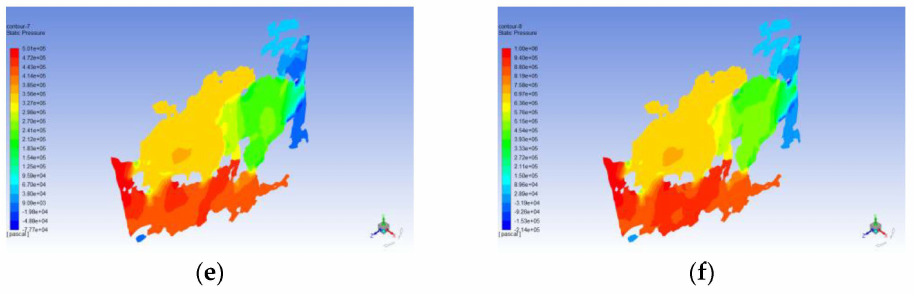
Figure 5. z negative inlet pressure cloud map: ( a ) 0.1 Mpa pressure cloud map. ( b ) 0.5 Mpa pressure cloud map. ( c ) 1 Mpa pressure cloud map. ( d ) 3 Mpa pressure cloud map. ( e ) 5 Mpa pressure cloud map. ( f ) 10 Mpa pressure cloud map.